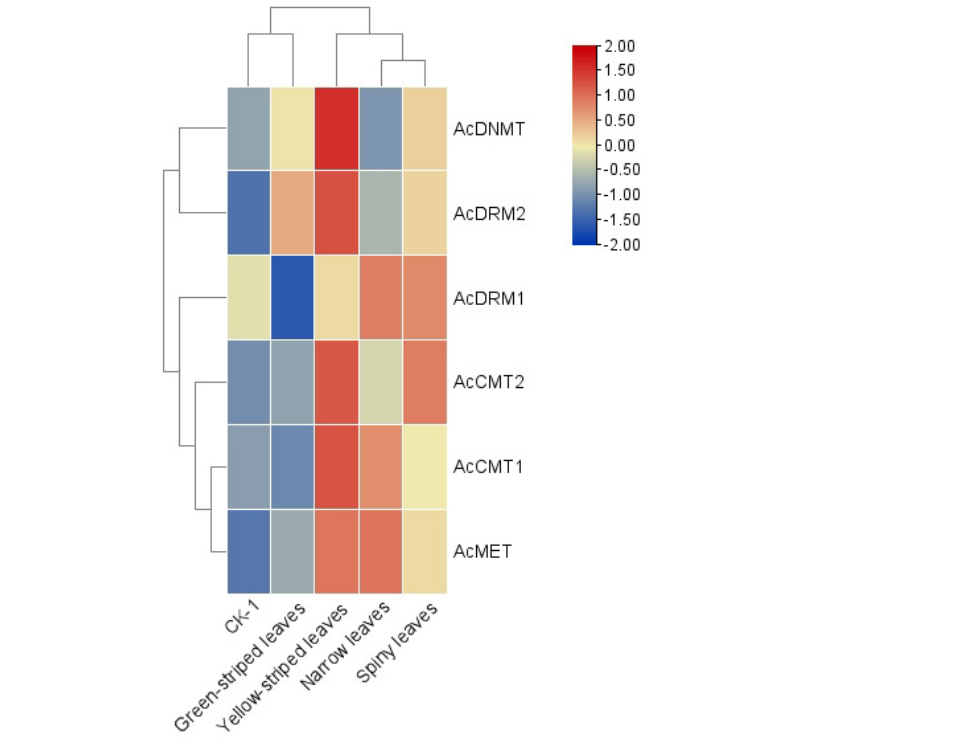
Figure 7. DNA methylation levels and gene expression of variation of pineapple leaves. Scale bar at right of the heat map. The expression values represent log2-transformed fragments per kilobase of exon per million fragments mapped.